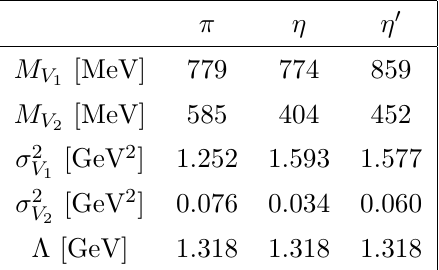
Table 5. Parameters of the alternative model for pion, (cid:17) , and (cid:17) 0 TFFs. does not change. The large- N Regge model for the (cid:17) ( 0 ) TFFs is then constructed such c that each vector-meson pair contributes exactly C P = N to F , where N is the nor- (cid:17) ( 0 ) (cid:13)(cid:13) V 1 V 2 malization